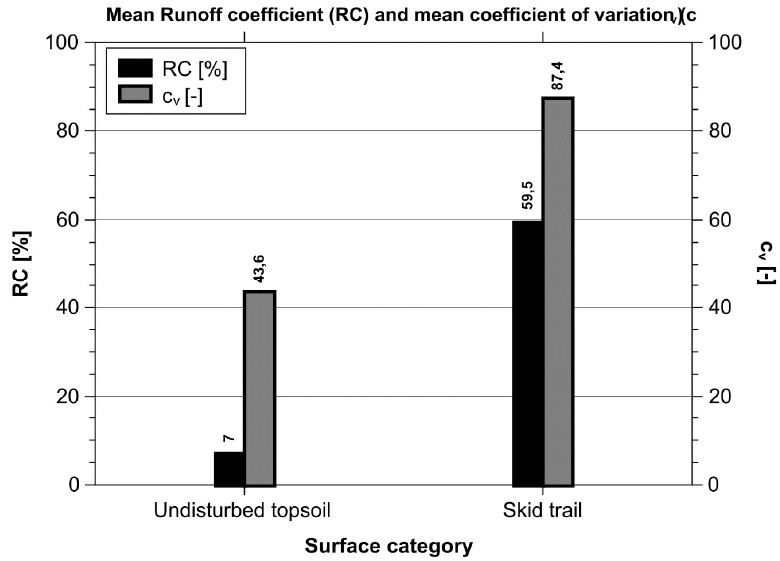
Figure 8. Mean runo ff coe ffi cients (RC) and mean coe ffi cients of variation (c v ) for each surface category. RC was 8.5 times higher on skid trails than on undisturbed sites, while c v was twice as high on skid trails compared to forest soil. Both values indicate noticeable changes of soil hydrological responses to heavy rainfall